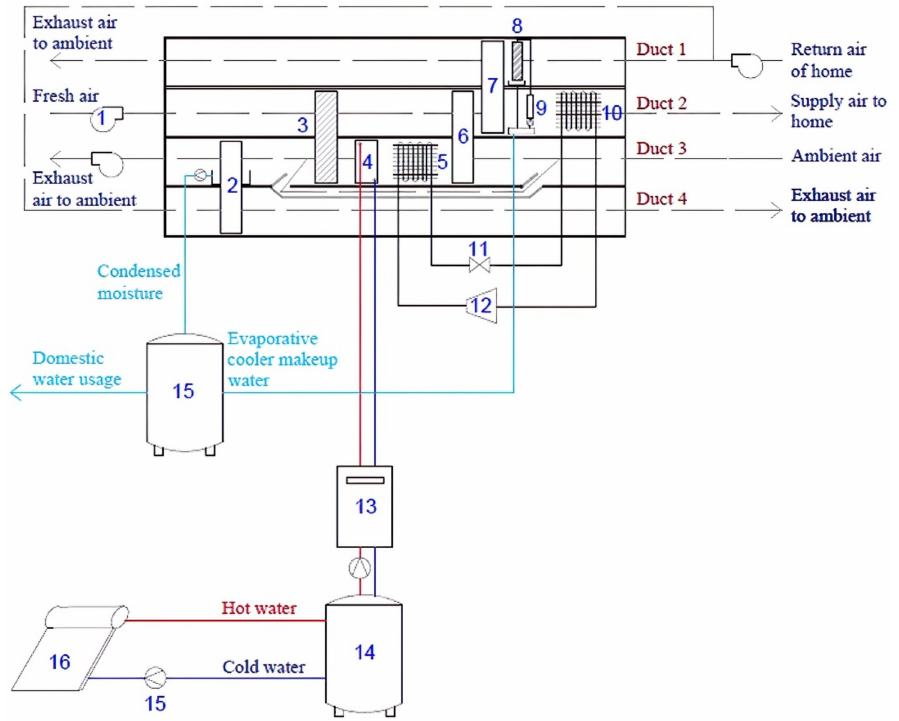
Figure 8. Scheme of novel desiccant cooling system with water production function